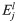
Context and goal input vectors to expert Ejl.Both are collections of top-down and lateral inputs from other Experts from the previous time step. The Goal input has some parts masked-out (blue parts). The resulting two input vectors can be interpreted as a high-level description of the current state, and a passive prediction of what will happen next (xjl(T), xjl(T+1)), and the goal as a preference (measured in the expected value of reward) for the next state. Note that in this figure, the variable t denotes the time for the Expert receiving the context (Ejl), while T denotes the time for an Expert sending the context. Because all Experts are event driven, the time between two changes in an Expert states is different for different Experts.